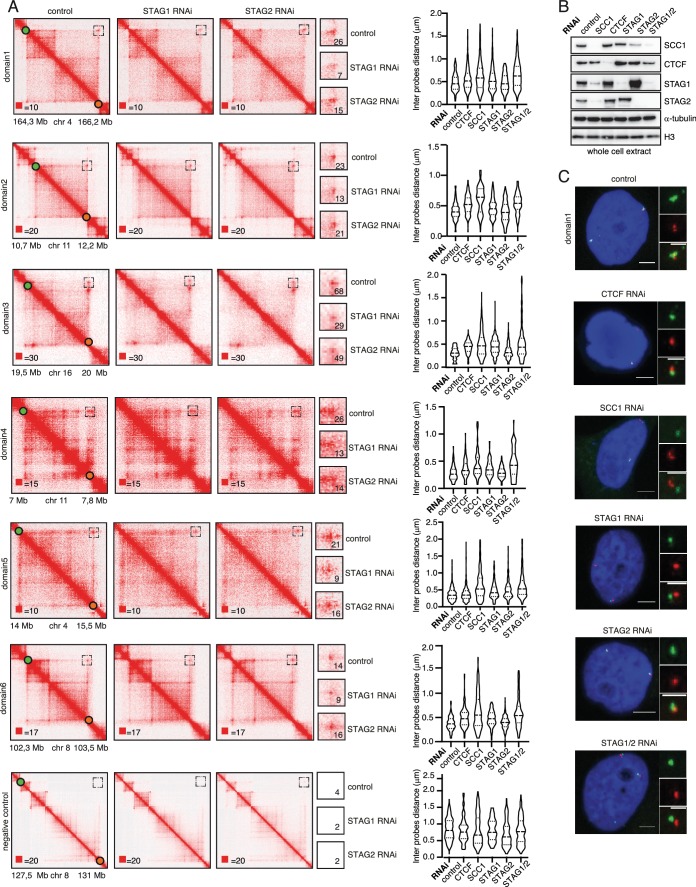
STAG1 depletion reduces loop signal more than STAG2 depletion.(A) Coverage-corrected Hi-C contact matrices of loci used in FISH analysis from control-, STAG1- and STAG2-depleted HeLa cells are shown on the left. The matrices were plotted using Juicebox. Boxed regions (also shown at higher magnification in the middle panels) represent the loop loci used in the FISH analysis. The numbers denote the most densely populated square at highest resolution within the range of the loop coordinates targeted by FISH probes. The right panel shows violin plots of the FISH 3D distance measurements between the loci boxed on the Hi-C matrices. The dashed lines show the median and interquartile range of between 100 and 500 cells for each condition. (B) Immunoblot analysis of whole cell extracts from HeLa cells depleted for proteins as indicated using RNAi. Immunoblotting was performed using the indicated antibodies. α-tubulin and histone H3 were used as loading controls. (C) Representative FISH images from HeLa cells depleted of the indicated proteins. Scale bar, 10 µm.